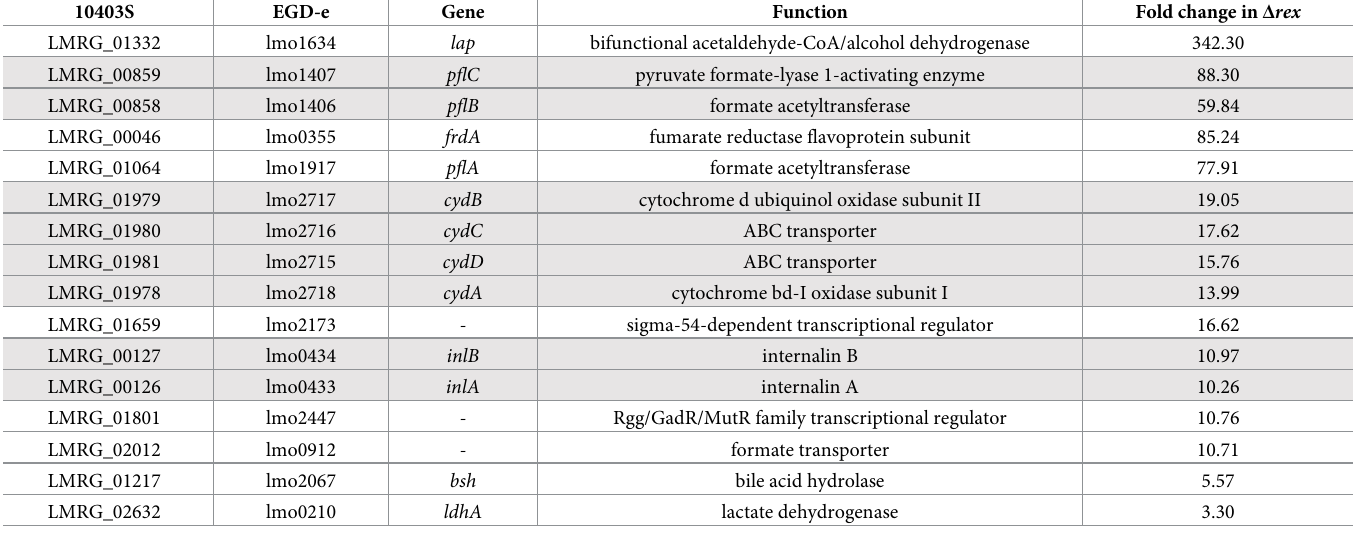
Highlighted genes are predicted to be in an operon